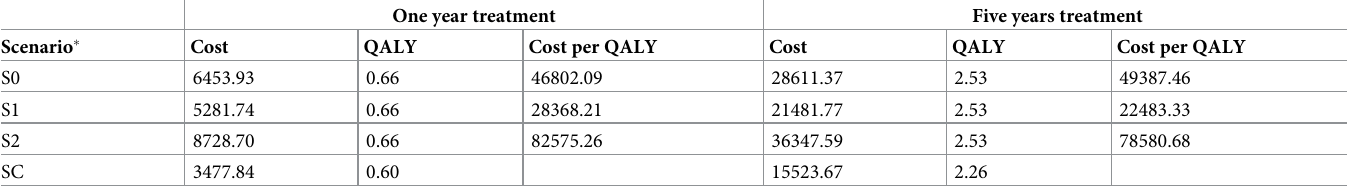
Table 11. Cost-effectiveness results for FlowOx ™ therapy (continuous treatment) compared to standard